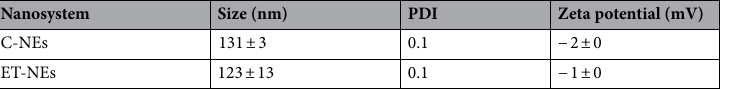
Table 1. Physicochemical properties of edelfosine nanoemulsions (ET-NEs) and the control formulations